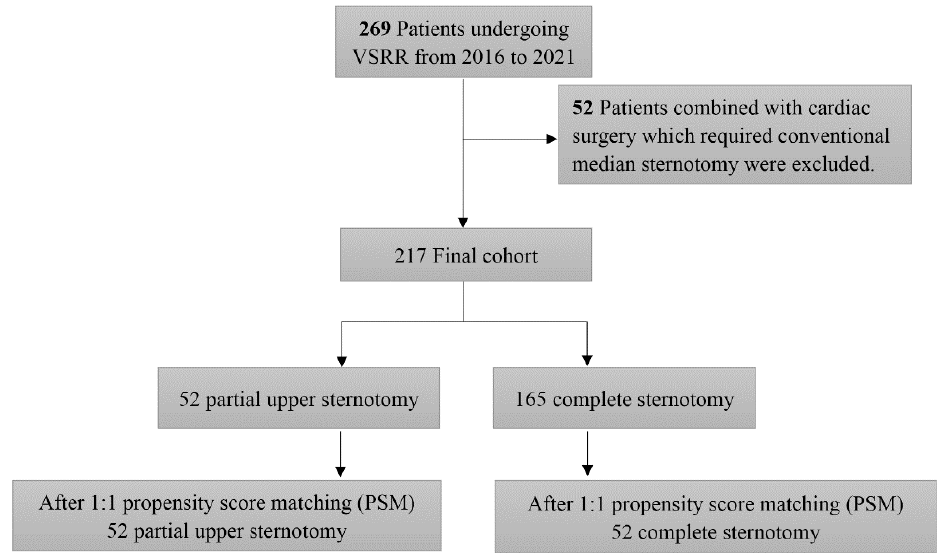
Figure 1. Study design: summary of the inclusion and exclusion criteria of the study population.